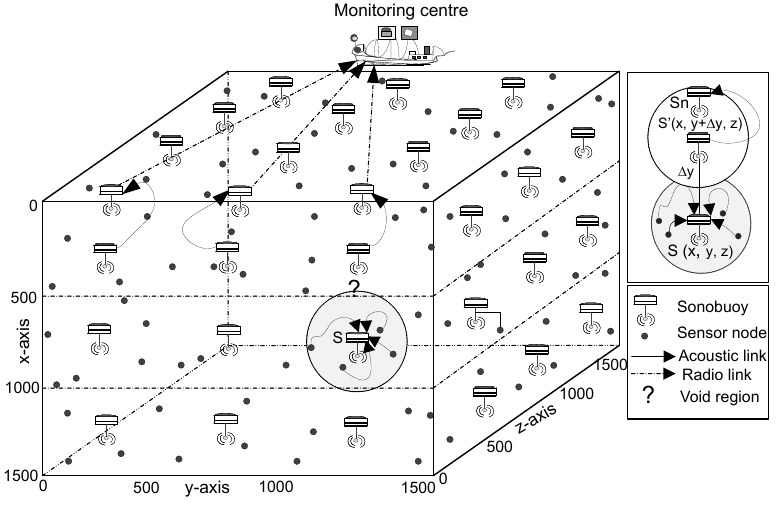
Figure 4. Schematic diagram of